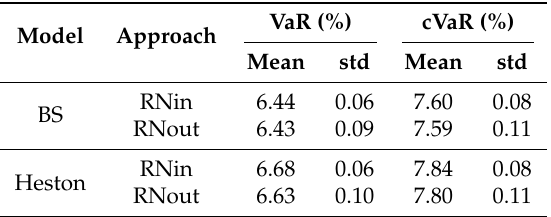
Table 5. Mean and std of VaR and cVaR with external and internal RN